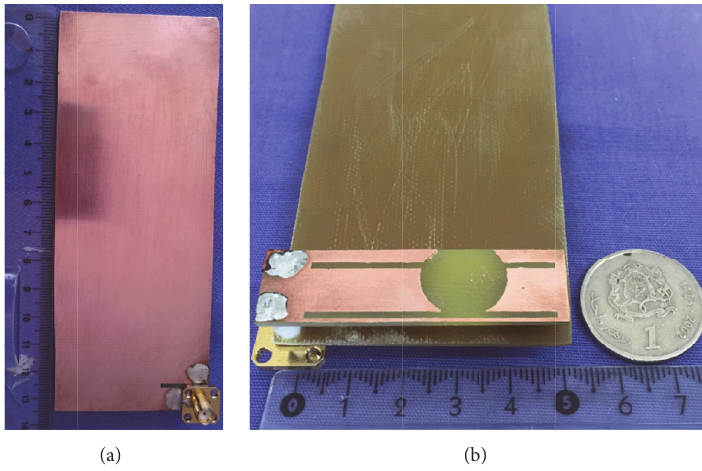
Figure 6: The manufactured PIFA: (a) ground plane and (b) radiating patch.